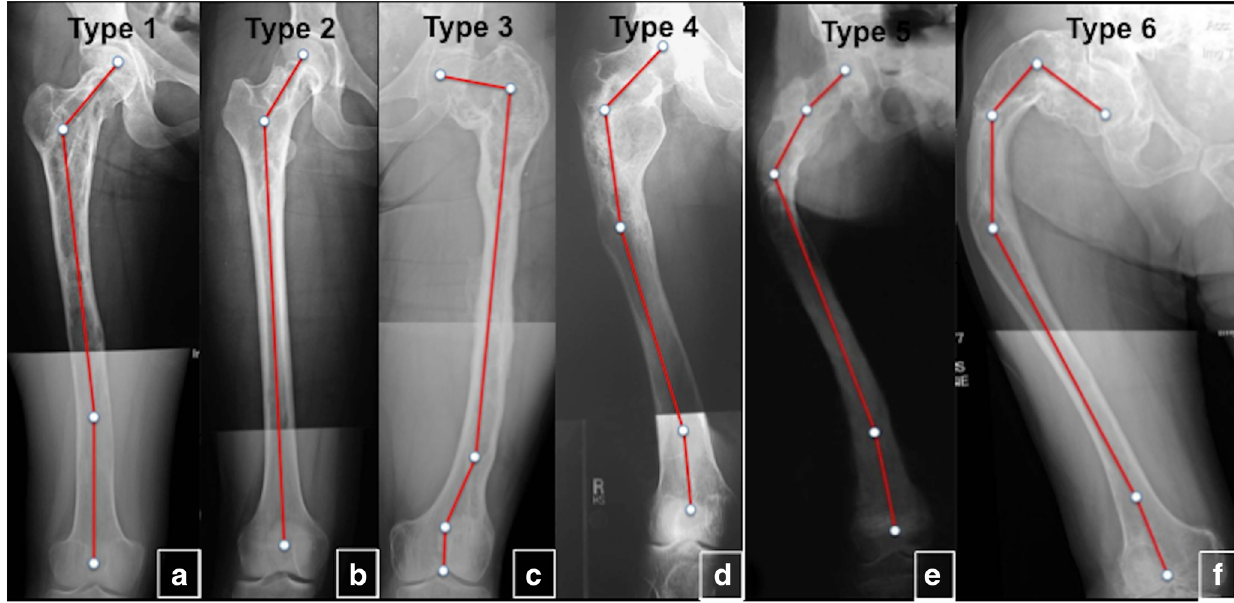
Fig. 23 The classification of femur deformities in fibrous dysplasia (FD). a Type 1. The neck-shaft angle is within normal limits (135°), but a distal femur shows 16° valgus deformity. b Type 2. The neck-shaft angle is valgus (152°). c Type 3. The neck-shaft angle is varus (100°). A distal shaft 10° demonstrates varus deformity. Distal juxta-articular valgus deformity is also present. d Type 4. The neck-shaft angle is normal (125°). Proximal lateral (shepherd ’ s crook) and distal medial bowing of